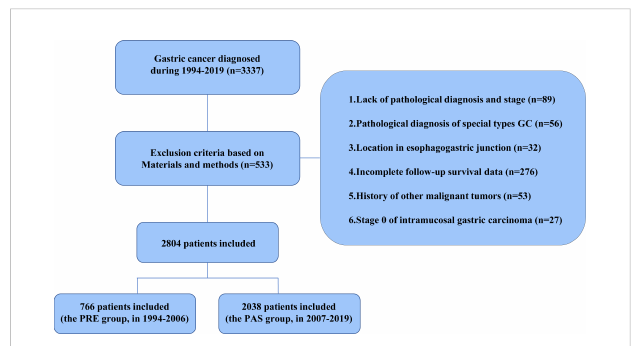
FIGURE 1 Flow chart of the selection of gastric cancer patients in the